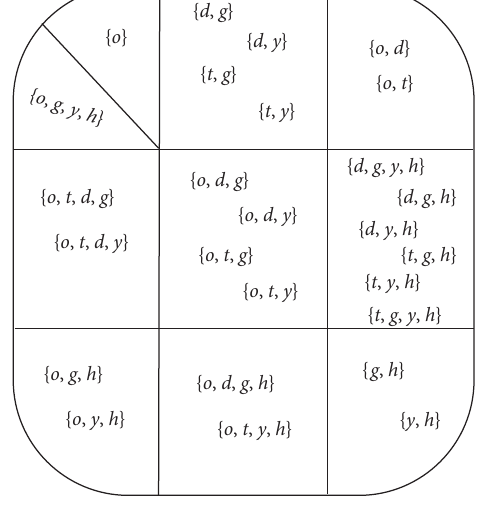
Figure 2: Approximation space ( M , ψ ) .